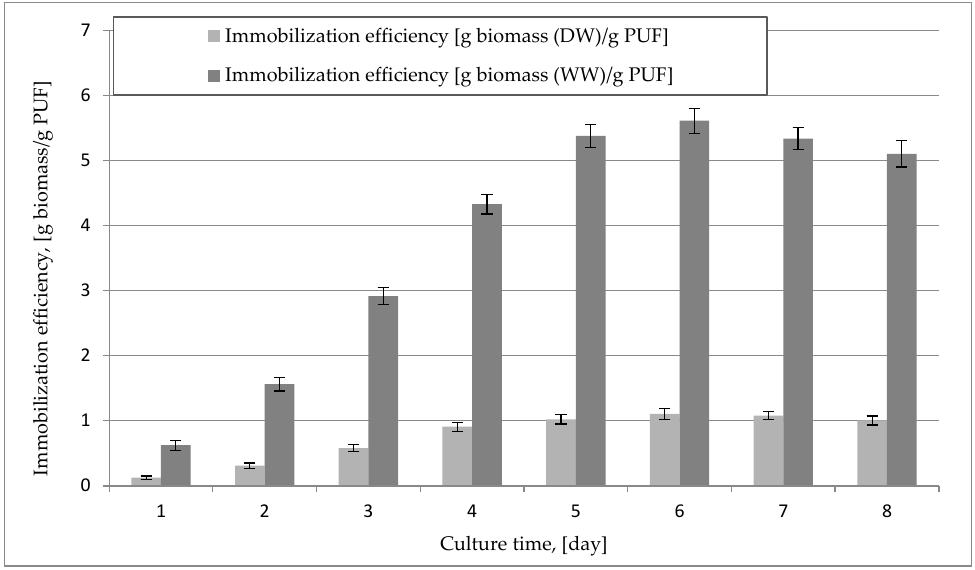
Figure 2. The efficiency of immobilization of B. adusta DSM 3375 mycelium in a polyurethane carrier during 8 ‐ day cultivation.